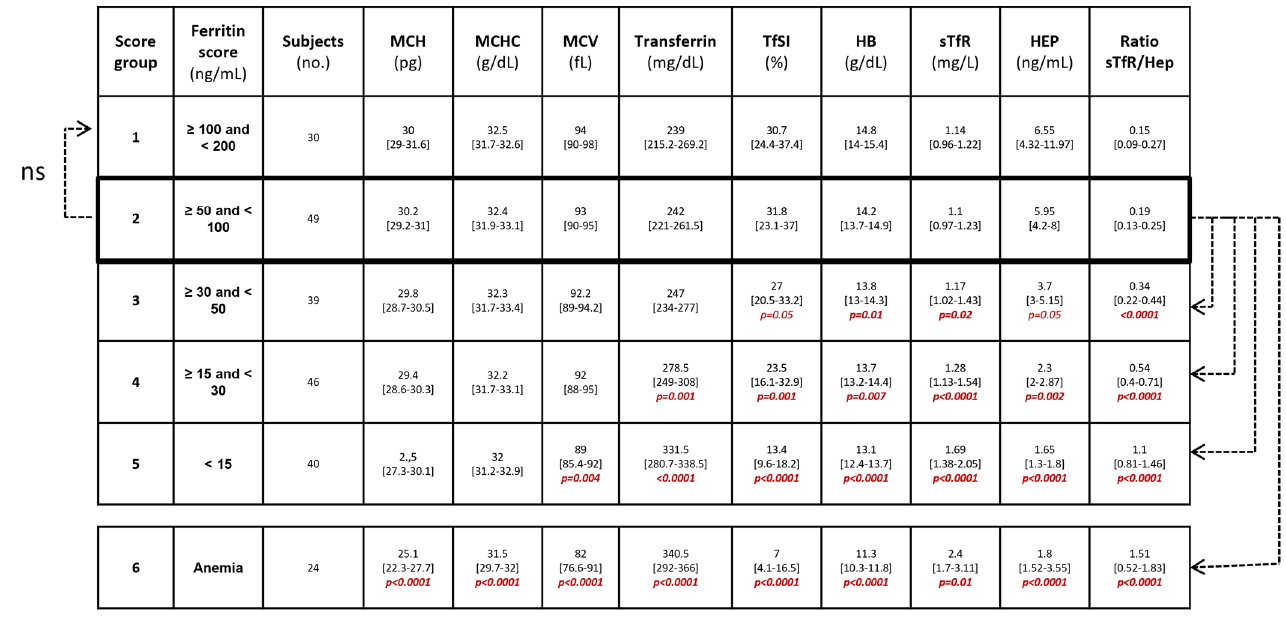
Figure 2. Comparisons of iron biomarkers between different ferritin score groups and anemic subjects. All score groups were compared with group 2, which was considered as the reference group. Abbreviations: HCH, mean corpuscular hemoglobin; MCHC, mean corpuscular hemoglobin concentration; MCV, mean corpuscular volume; TfSI, transferrin saturation index; HB, hemoglobin; sTfR, soluble transferrin receptor; HEP, hepcidin. Continuous variables are expressed as the medians and interquartile ranges (IQR). Categorical variables are expressed as numbers and percentages. Differences between variables and groups were determined by using the Mann–Whitney U-test. ns: not statistically significant.